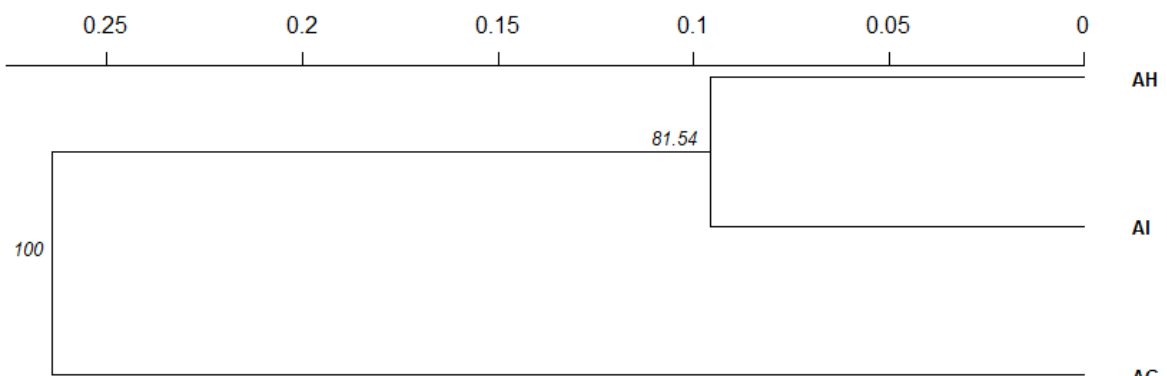
played in the upper left bar chart (R package adegent 2.0.0). AG— Alnus glutinosa , AI— A. incana , AH—hybrids.